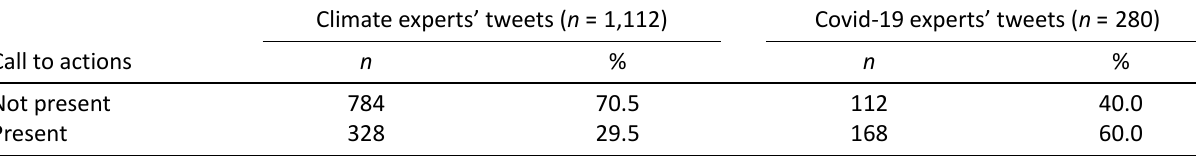
Table 2. Advocating behaviour in experts’ tweets addressing politics ( n =